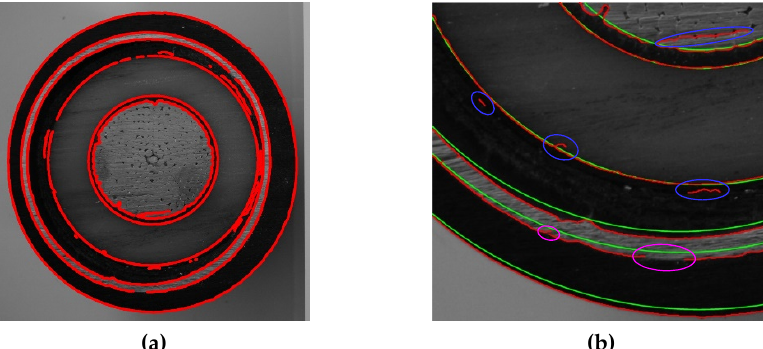
Figure 20. Layering result of edge points. ( a ) Layered edges plotted in red dots; ( b ) Partial enlargement of ( a ), in which red dots are layered edges, green lines are the fitted circular contour, and interferences and discontinuity exist in blue and magenta ellipses.